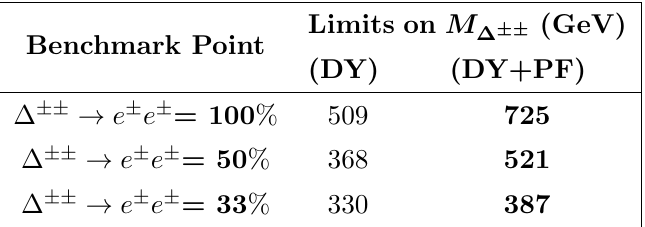
p using ATLAS results at s = 13 TeV (cid:1) (cid:6)(cid:6)